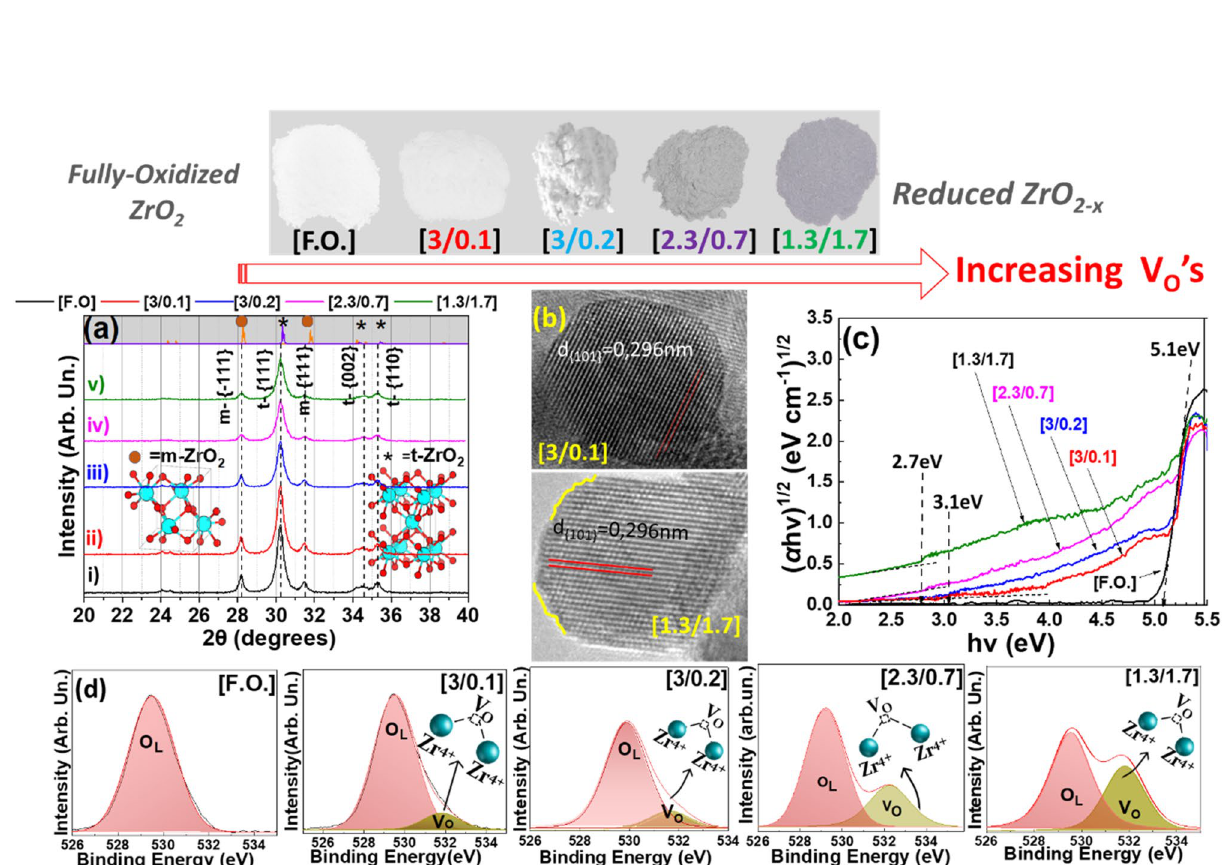
Figure 2. ( a ) XRD of FSP-made ZrO 2 − x materials, ( b ) TEM images for [3/0.1] and [1.3/1.7] materials, ( c ) Kubelka–Munk plots DRS UV–Vis spectra. ( d ) XPS spectra of F.O., [3/0.1], [3/0.2], [2.3/0.7] and [1.3/1.7]. Top- Inset : Photos of the